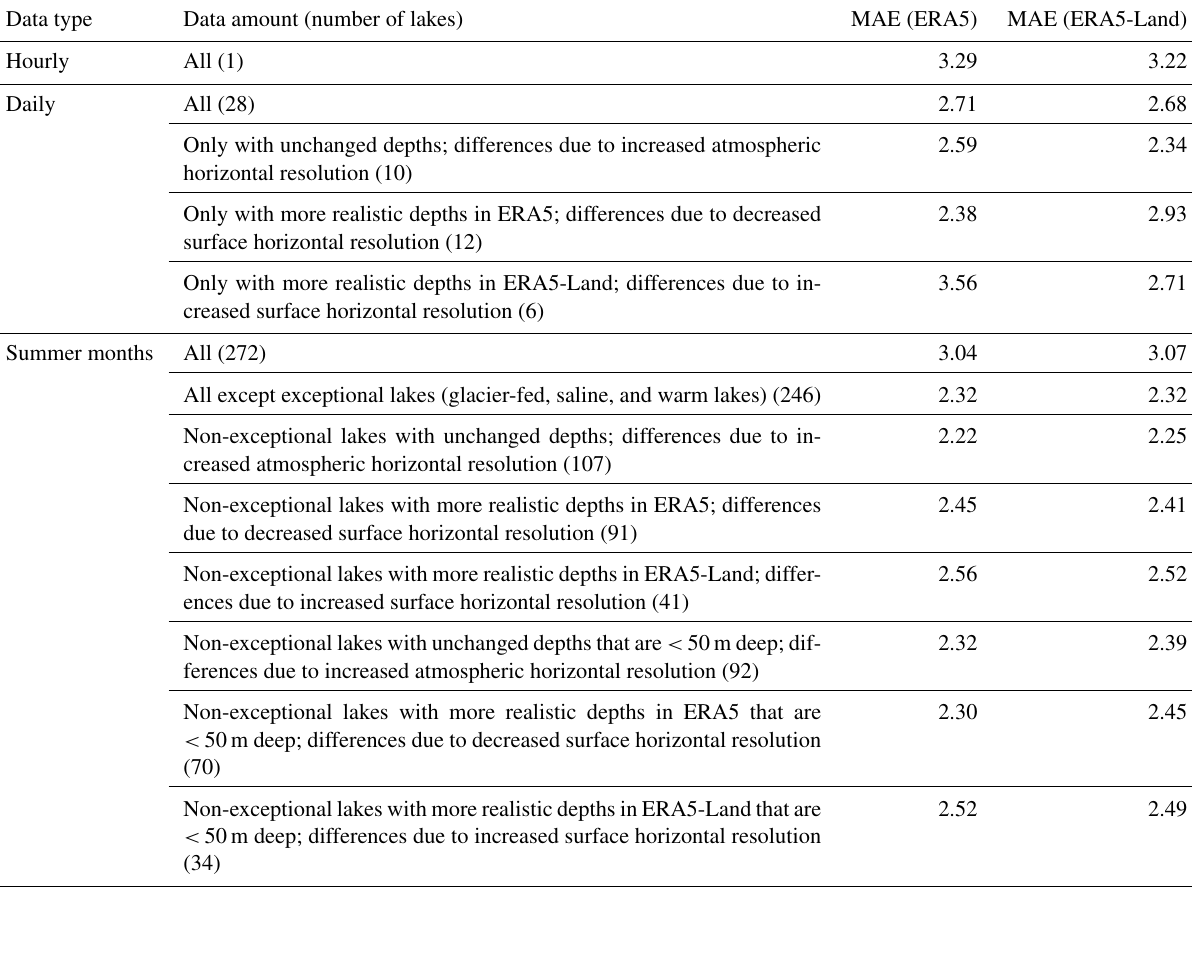
Table 4. MAEs of the ERA5 and ERA5-Land LSWT estimates compared to in situ hourly, daily, and 3-summer-month average LSWT data. Hourly data correspond to data from the Alqueva reservoir in Portugal (2017 and 2018); daily data are from the Finnish lakes (2000–2016) and averaged hourly data from the Alqueva reservoir; summer month average data are from a global inventory (1985–2009) and the Finnish lakes. The first column is for the data type (hourly/daily/summer month average), second column provides the number of lakes for each category, third column shows the MAE ( ◦ C) of ERA5 LSWT estimates compared to in situ measurements, and fourth column is the same as third column but for ERA5-Land.